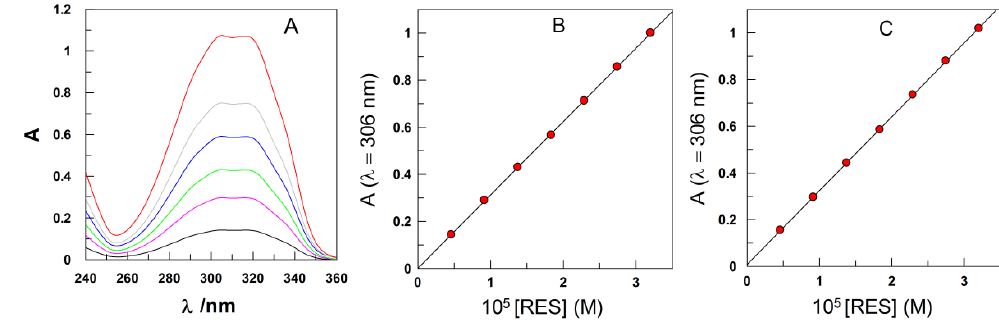
Figure 1. ( A ) Spectra of RES in water at different [RES]; ( B ) Beer’s law plot for RES in water (A = (7 ± 27) × 10 − 4 + (31,187 ± 130) [RES]); ( C ) calibration curve in a 50:50 (vol:vol) EtOH/BuOH mixture containing 40 µL of corn oil (A = (7.6 ± 2) × 10 − 4 +